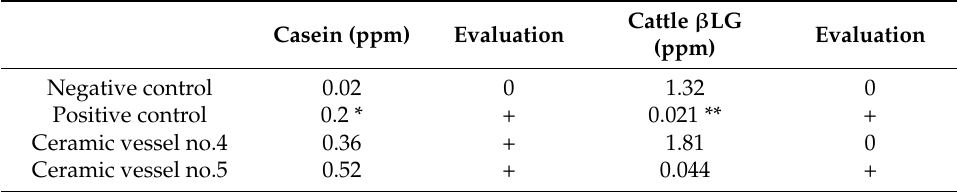
Table 2. Results of the casein sandwich ELISA test and of the cattle β -lactoglobulin ( β LG) competitive ELISA test used for the analysis of bottom soil layer samples taken from the studied vessels. Cattle β LG Evaluation Casein (ppm) Evaluation (ppm) Negative control 0.02 0 1.32 0 Positive control 0.2 * + 0.021 ** + Ceramic vessel no.4 0.36 + 1.81 0 Ceramic vessel no.5